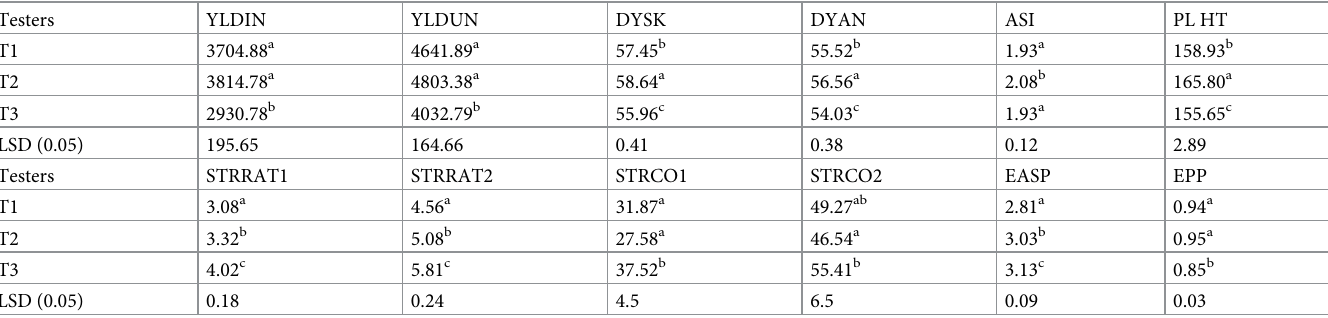
Table 3. Means, maximum, minimum and standard errors of agronomic and morphological traits for each tester evaluated across environments.